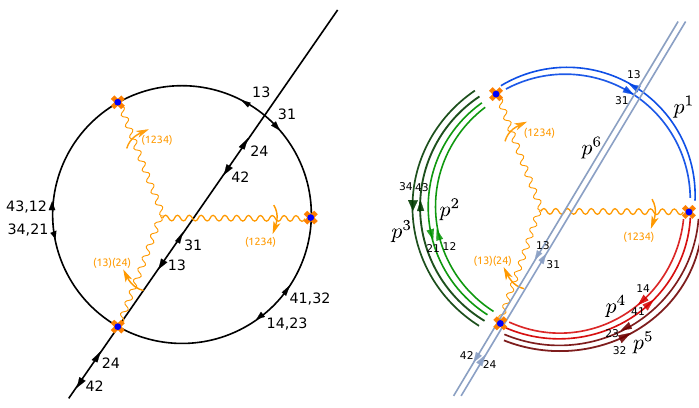
Figure 7 . Left: the spectral network of charge (cid:13) 1 + (cid:13) 2 . All the walls connecting the same punctures are degenerate. Right: a resolution of the same spectral